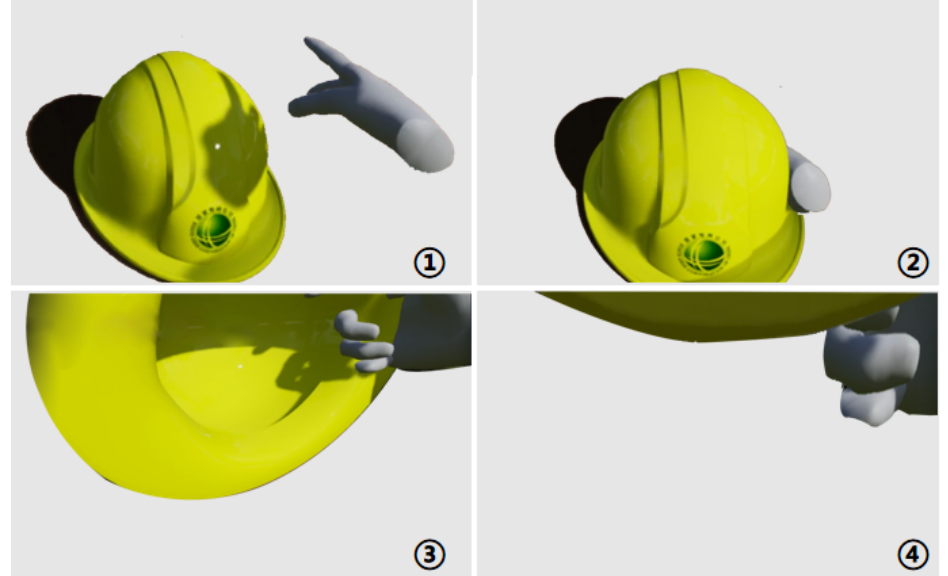
Figure 10. Operation of wearing helmet in a smart grid training